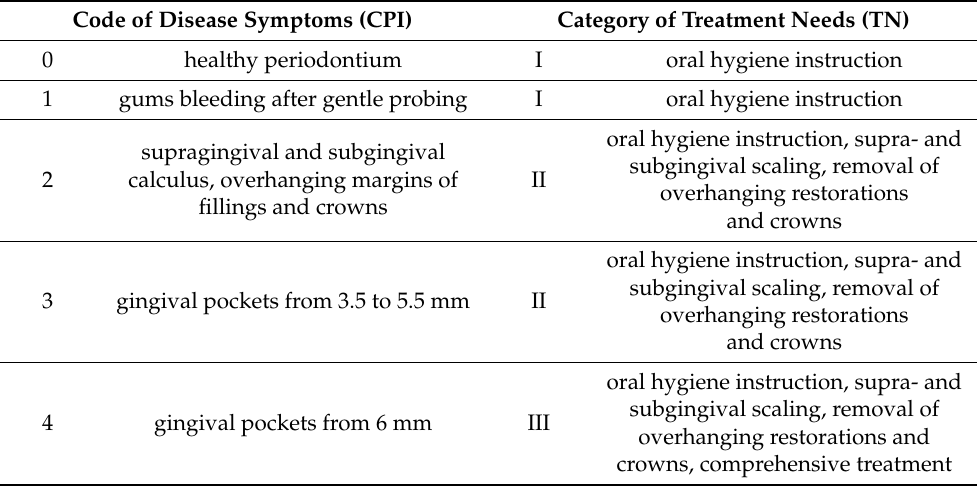
Table 1. Symptoms and categories of treatment needs according to CPITN. Code of Disease Symptoms